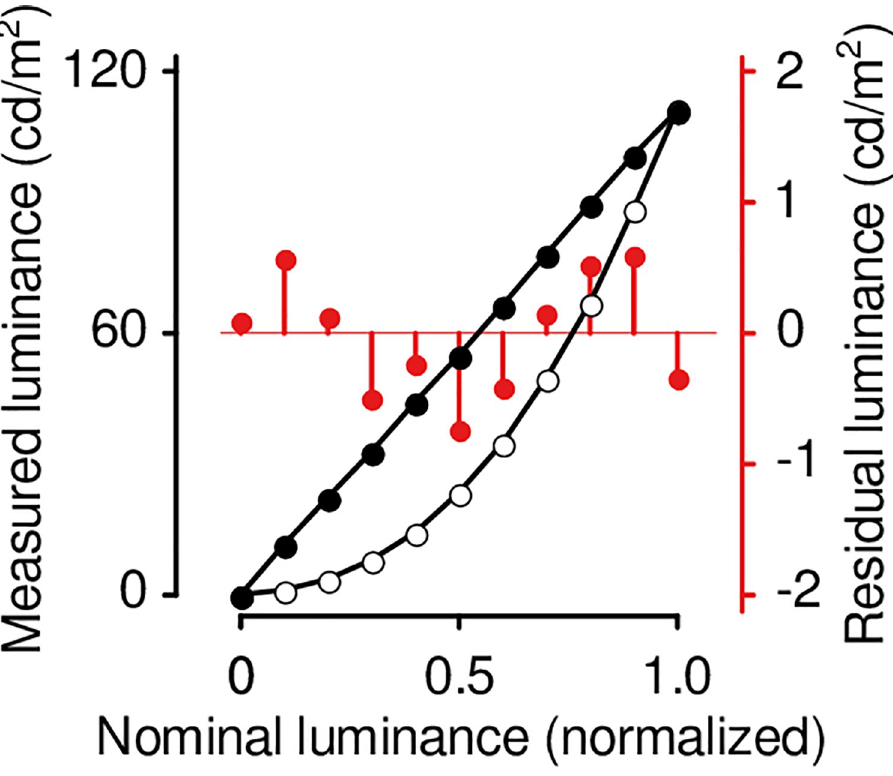
Fig 1. Example of display linearization. Open (closed) symbols show the U2415b’s response before (after) linearization. Red symbols show model residuals.